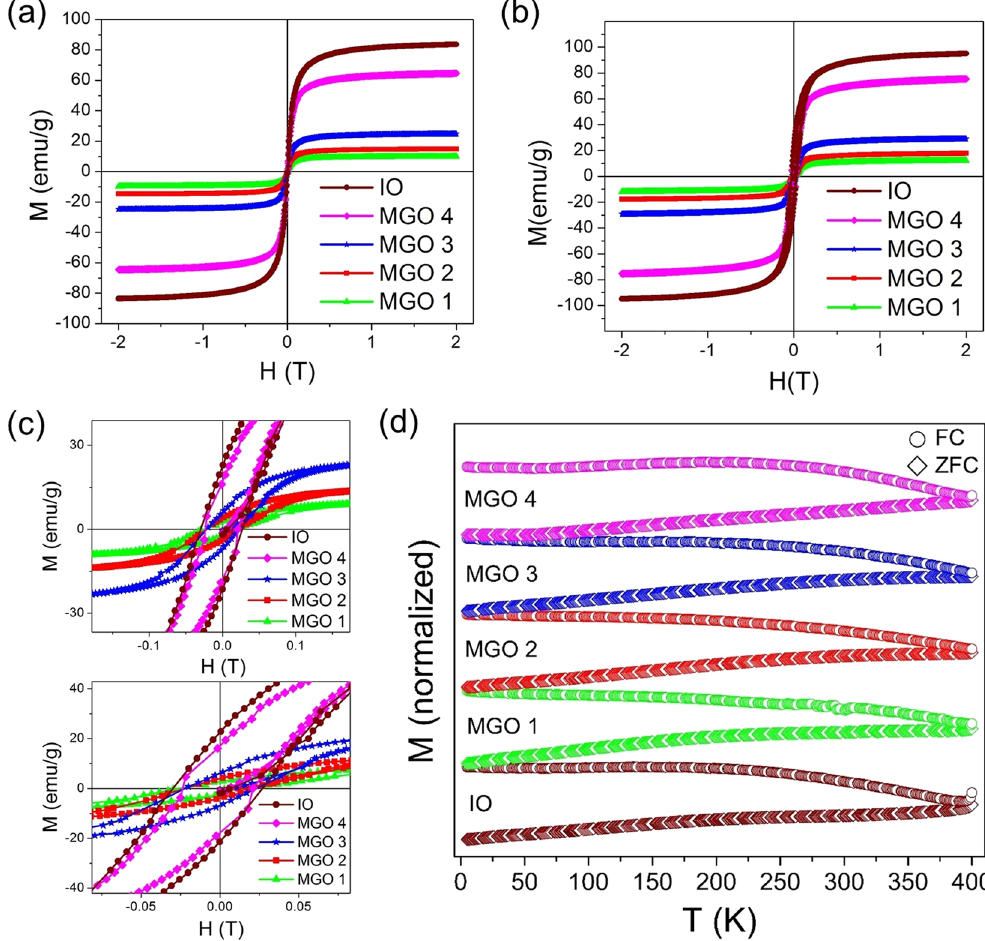
Figure 5. Magnetic hysteresis ( M–H ) curves of IO and MGOs measured at ( a ) 300 K and ( b ) 5 K ( c ) M-H curves in low magnetic field region showing negligible coercivity (d) FC and ZFC curves of IO and